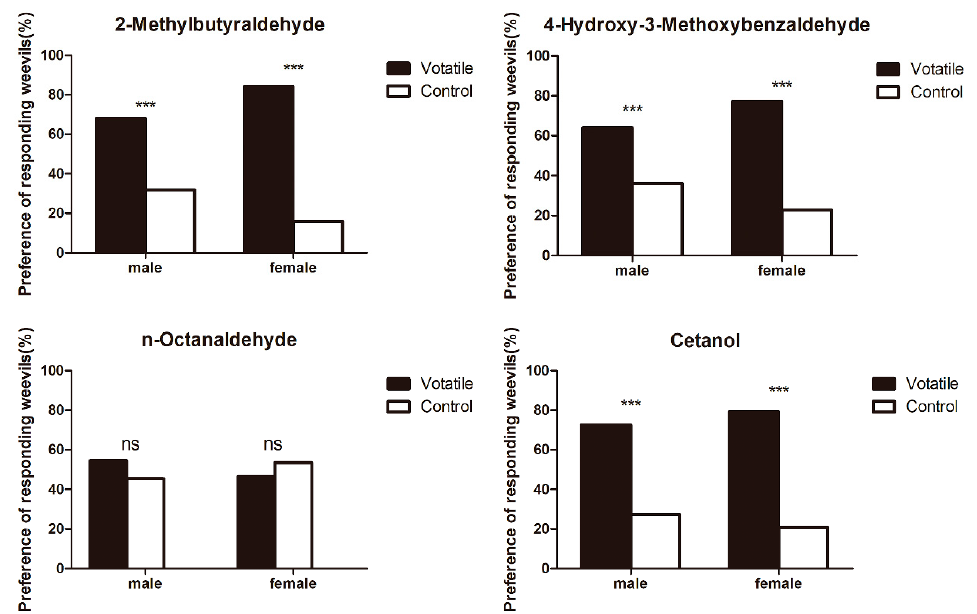
Figure 8. Responses of male and female Sitophilus zeamais adults to volatiles from four host plant combinations in the Y-tube olfactometer assays. Activity is expressed as percentage of weevils responding, and bars followed by different markers indicate significantly different activity of the weevils between the treatments ( p < 0.05). The mean values shown are predicted values from regression analysis. ‘*’ indicates significant differences from even distribution at * p < 0.05, or ** p < 0.01, *** p < 0.001. ‘ns’ indicates not significantly different.